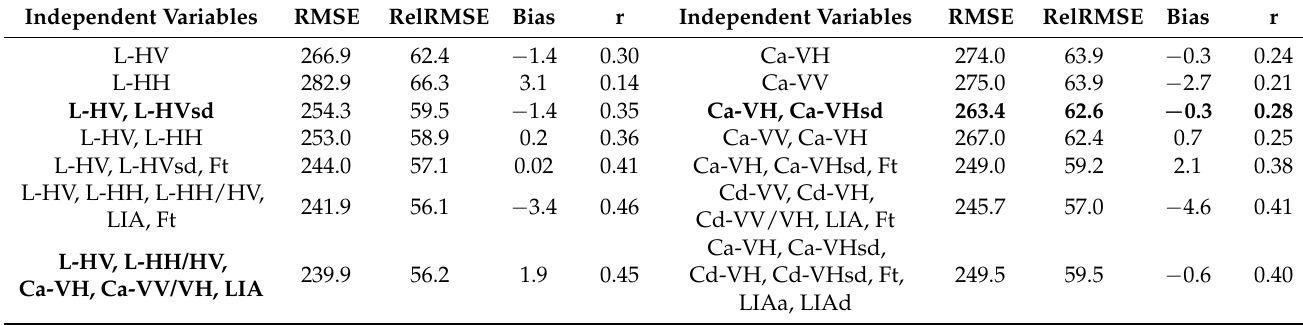
Figure 3. Scatterplots of cross-polarized backscatter coefficient as a function of growing stock volume (GSV) for all samples and by main forest species ( a – d ). Values show multi-temporal averages. Grey and black (dashed) lines show logarithmic model fit. Table 2. GSV accuracy as a function of the independent variables used for the single polarized models. Bold numbers show overall results for the models analyzed by GSV intervals in Figures 4 and 5. Abbreviations as follows: RMSE—root mean squared error, RelRMSE—relative RMSE, r—Pearson’s correlation coefficient, L—stands for L-band, C—stands for C-band, H—horizontal, V—vertical, a—ascending pass, d—descending pass, sd—standard deviation, Ft—forest type, and LIA—local incidence